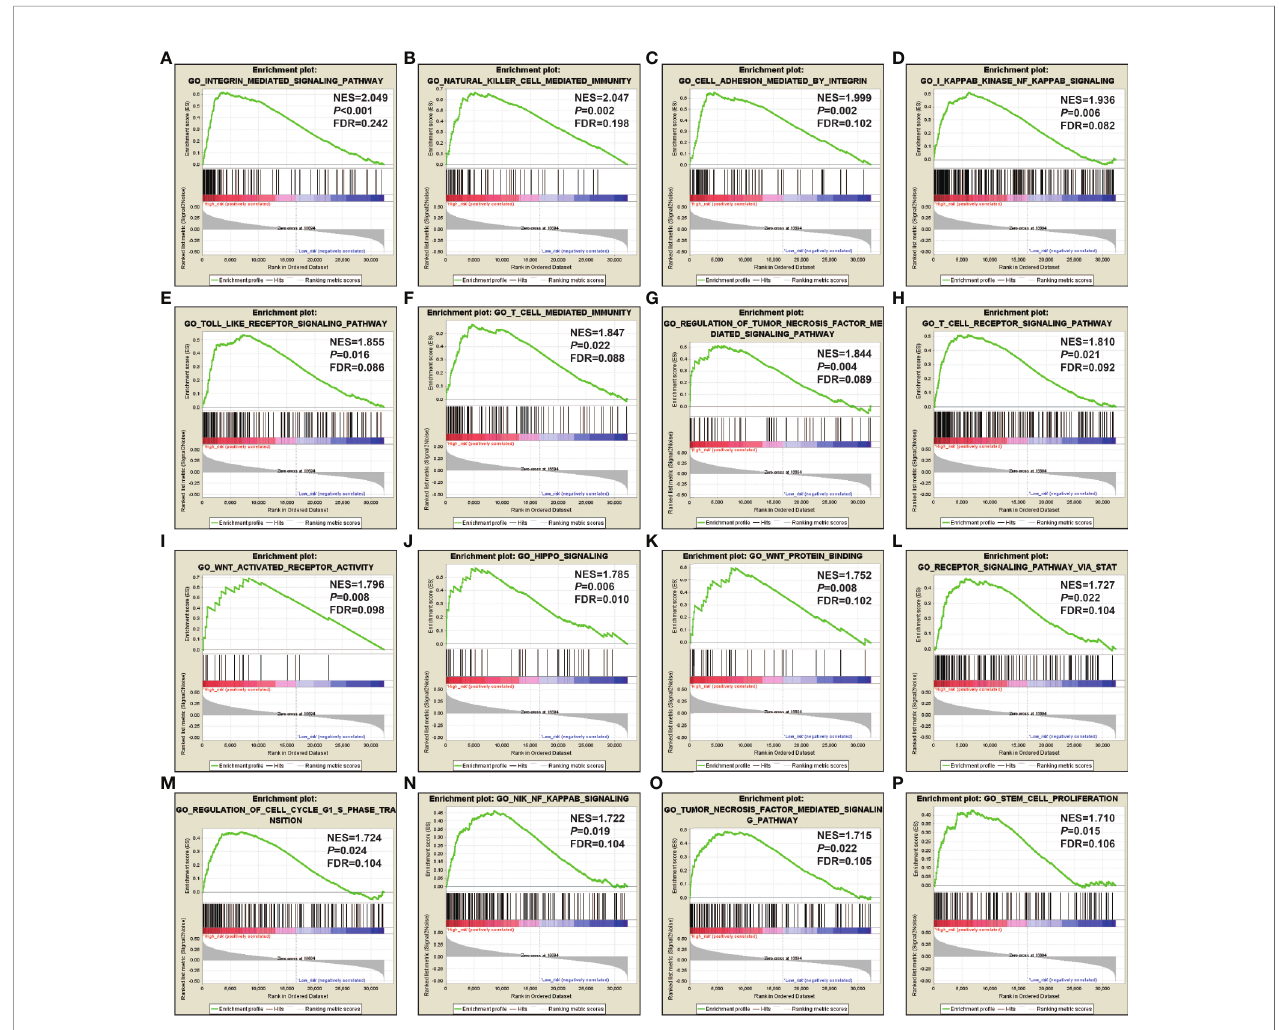
FIGURE 7 | GSEA results using the c5 reference gene set. (A) integrin mediated signaling pathway; (B) natural killer cell mediated immunity; (C) cell adhesion mediated by integrin; (D) kappa B kinase NF kappa B signaling; (E) toll like receptor signaling pathway; (F) T cell mediated immunity; (G) regulation of tumor necrosis factor mediated signaling pathway; (H) T cell receptor signaling pathway; (I) Wnt activated receptor activity; (J) hippo signaling; (K) Wnt protein binding; (L) receptor signaling pathway via STAT; (M) regulation of cell cycle G1/S phase transition; (N) NIK/NF kappa B signaling; (O) tumor necrosis factor mediated signaling pathway; (P) stem cell